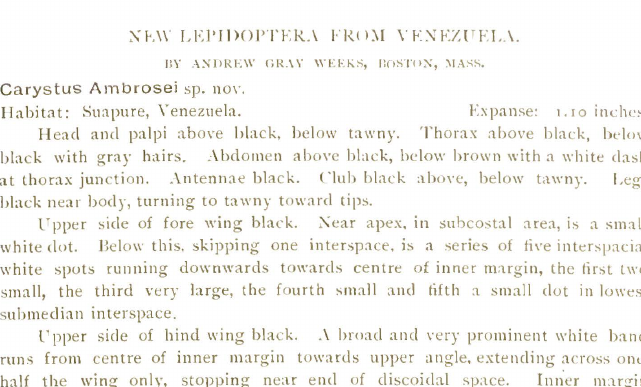
Expanse: 1.1o inches. Head and palpi above black, below tawny. Thorax above black, below black with gray hairs. :\bdomen abo\'e black, below brown with a white dash at thorax junction. .-\ntennae black. Club black above, below tawny. Legs black near body, turning to tawny toward tips. llpper side of fore wing black. Xear apex, in subcostal area, is a small white dot. Below this. skipping one interspace, is a series of fi,•e interspacial white spots running downwards towards centre of inner margin, the first two small, the third very large, the fourth small and fifth a small dot in lowest submedian interspace. l'pper side of hind wing black. .\ broad and very prominent white band runs from centre of inner margin towards upper angle, extending across one· half the wing only, stopping ne;tr end of discoidal space. Inn-er nurg-in slightly dusted with gray scales. illarginal fringes of ground color, turning to white at anal angle. Under side of fore wing the s;tme as upper surface except that the spots arc more closely connected and the ground color is brownish. llnder side of hind wing the same as upper surface except that the prominent band extends completely across the wing from a point neat the up· per angle on costa to centre of inner margin and of unvarying width. This band is creamy white. Variations: l\Iy small series of specimens shows no ,·ariations except that the two small subcostal spots arc sometimes wanting and the lowest dot, also, on fore wing. This species was not found in collections here, nor in the < ;odman co]. lection, British ;\]useum, etc. Taken in January,